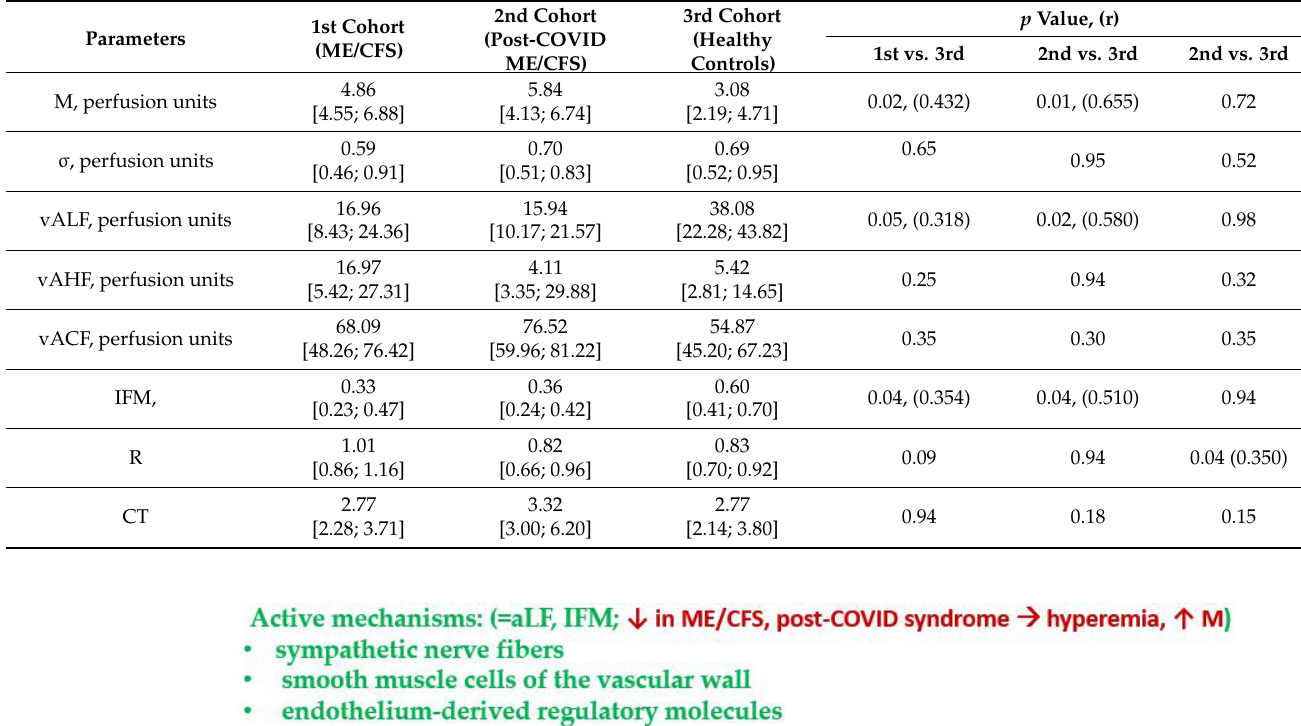
Table 8. Characteristics of microcirculation assessed with laser Doppler flowmetry in the participants with ME/CFS developed outside the context of COVID-19, in the participants with ME/CFS that developed after COVID-19, and in healthy controls. M—average value of tissue perfusion with blood, σ —mean square deviation of M oscillations in a given time interval, vALF—contribution of low-frequency oscillations (0.05–0.2 Hz) to the total power of the spectrum of biorhythms; vAHF— contribution of high-frequency oscillations (0.2–0.4 Hz) to the total power of the spectrum of biorhythms; vACF—contribution of pulse frequency oscillations (0.8–1.6 Hz) to the total power of the spectrum of biorhythms; IFM—the oscillation index; R—vascular resistance; CT—microvascular tone, r—effect size.